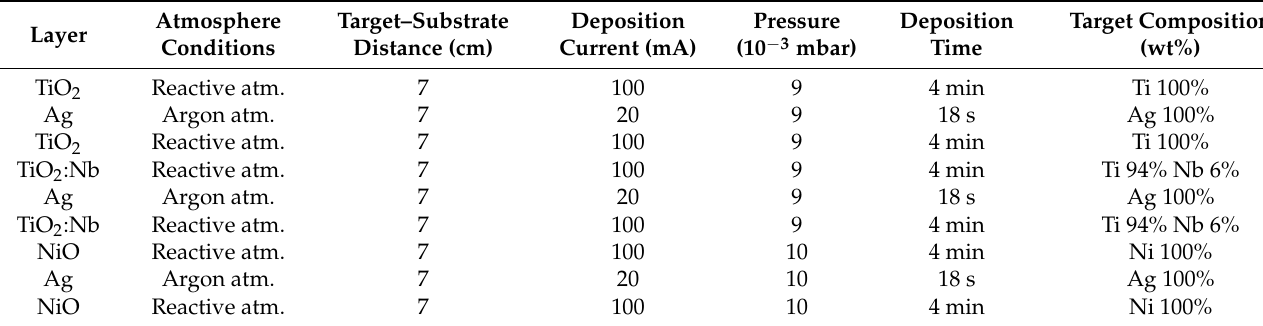
Table 1. Deposition conditions for the